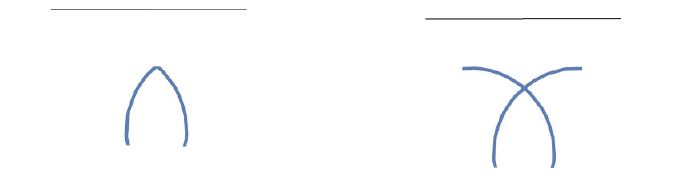
Figure 5 . Left: a domain wall intersection that would allow both an r max and an AlAdS boundary (straight line at top of (cid:12)gure), but which does not satisfy conservation of the stress-energy tensor. Right: a domain wall intersection that conserves the stress-energy